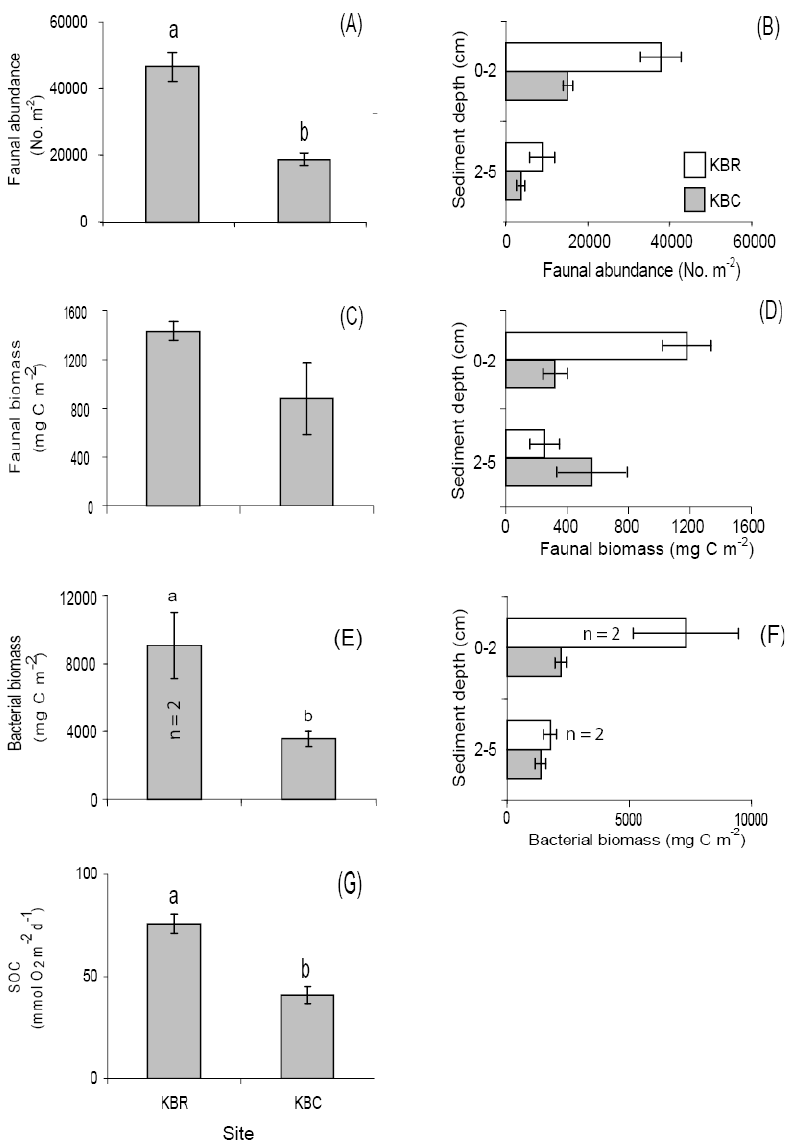
Fig. 4. Total and vertical distribution of macrofauna abundance ( A and B , respectively), biomass ( C and D , respectively), and bacterial biomass ( E and F , respectively) in cores from all Kaneohe Bay sites. Sediment oxygen consumption rates in cores from all Kaneohe Bay sites is shown in (G) . Significant differences ( P < 0 . 05) in parameters between sites are designated by different letters. Error bars denote ± 1SE ( n = 3) unless n = 2, where error bars denote ± range of two samples because of insufficient sample for PLFA analysis from a 3rd replicate